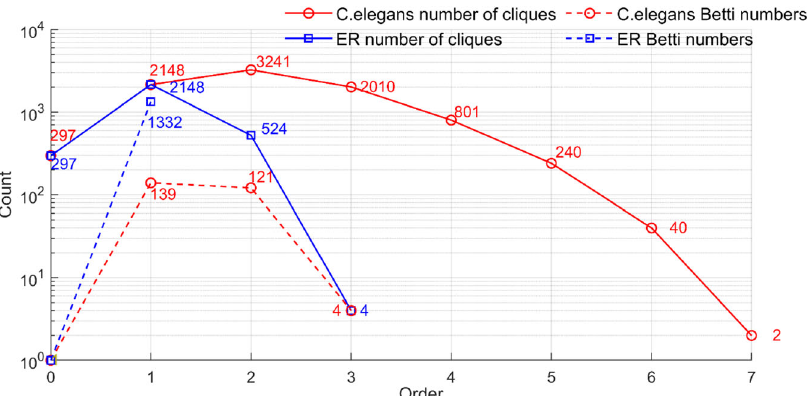
Fig. 2 Cliques and Betti numbers. The number of cliques and the Betti numbers for the C. elegans neuronal network versus the Erdös-Rényi (ER)